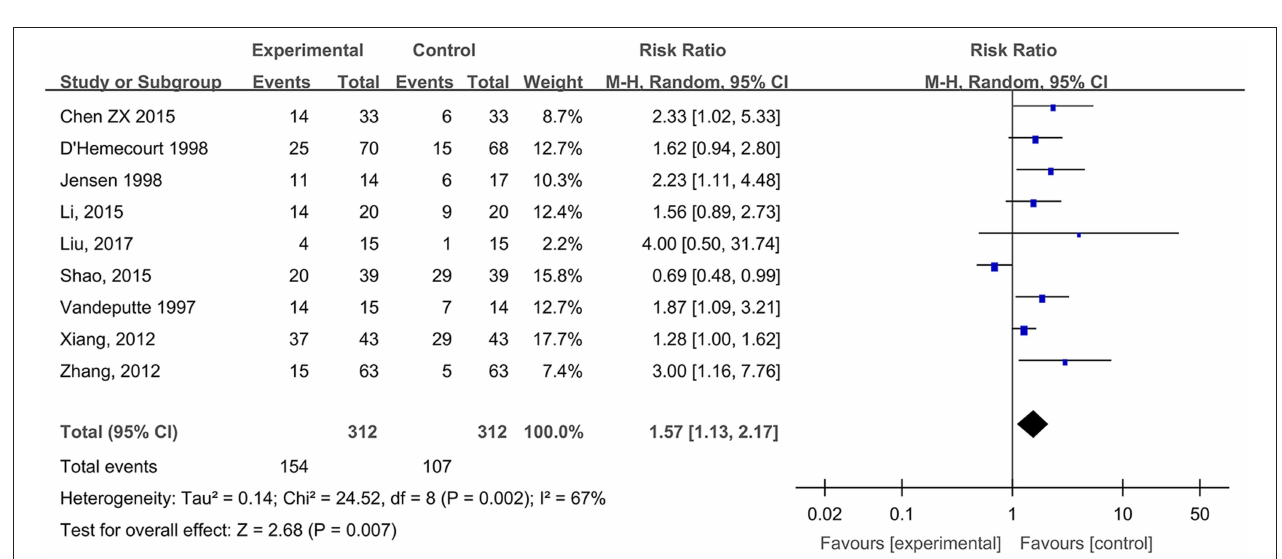
FIGURE 6 | Comparative meta-analysis of wound cure rates of diabetic foot ulcers.